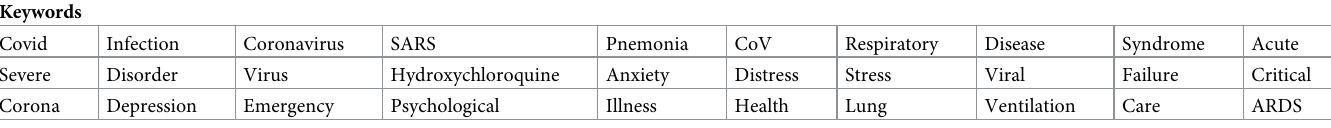
Table 5. The top 30 keywords with respect to average TF-IDF